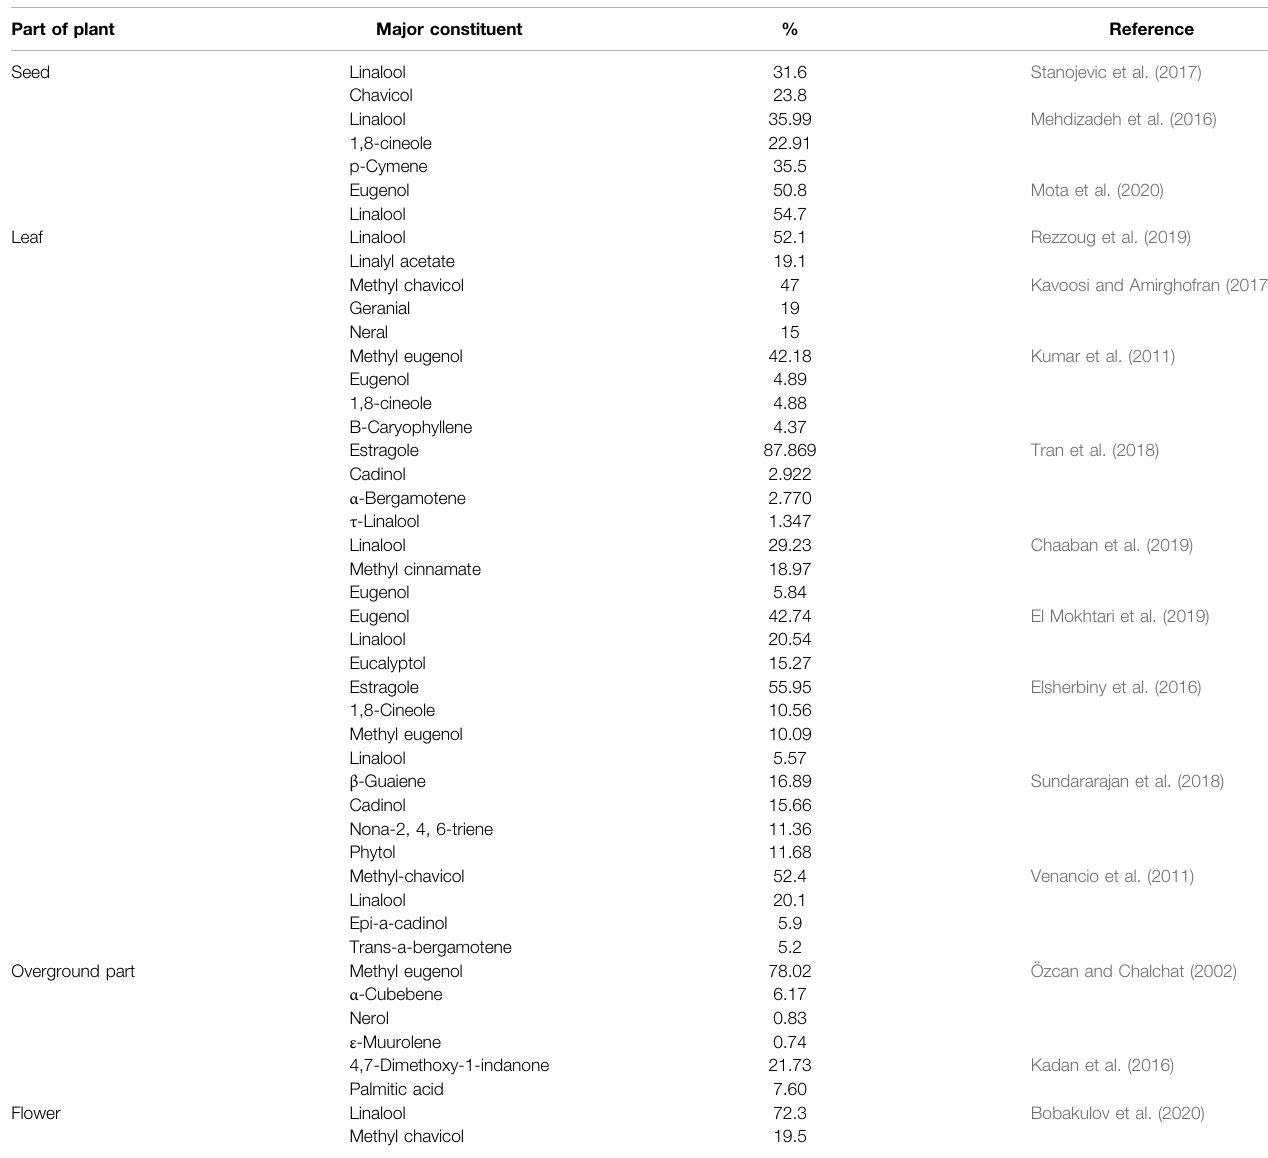
TABLE 1 | Chemical composition of O. basilicum . Part of